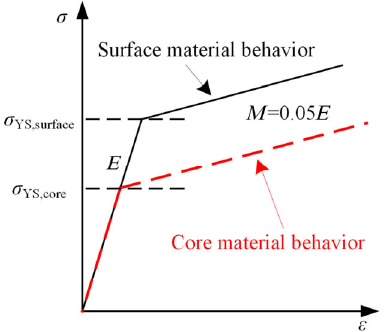
Fig. 8 Material constitutive